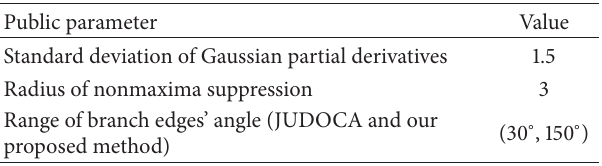
Table 1: Other experimental parameters